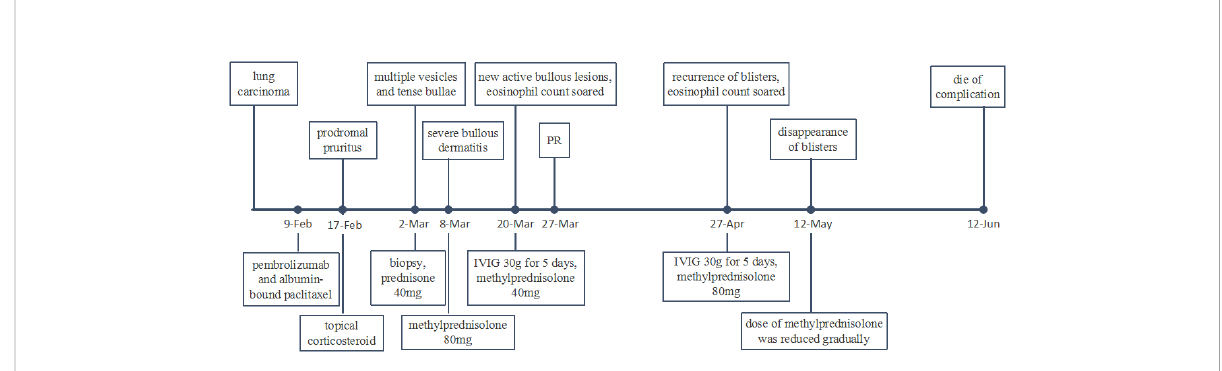
FIGURE 4 Case timeline. PR, partial